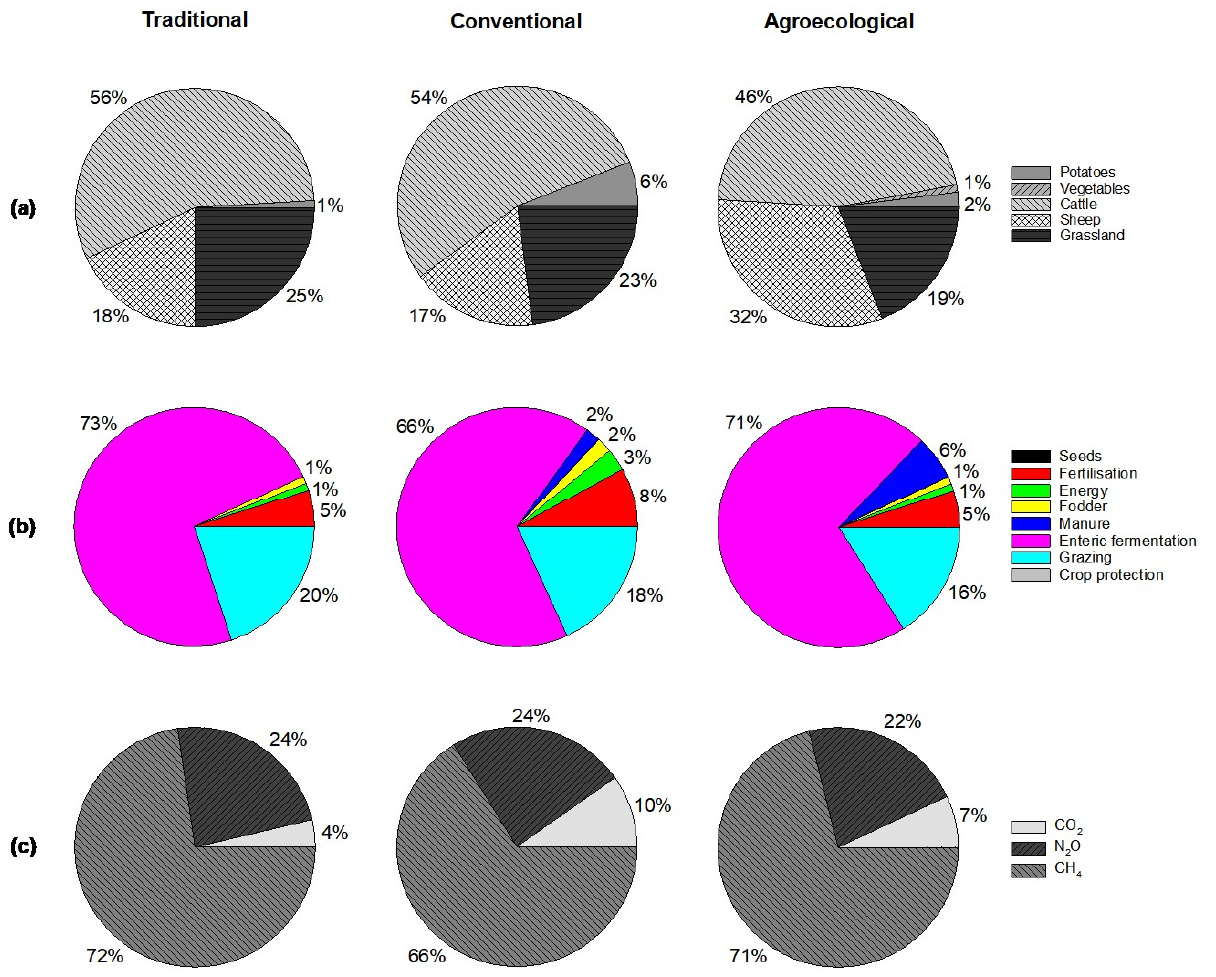
Figure 5. Contribution by sector to the total sum of emissions for each agricultural system: ( a ) contribution by crop and animal categories, some categories are not present in the pie charts because their contribution to total emissions is less than 1%; ( b ) contribution by specific activity or management practice, some categories are not present in the pie charts because their contribution to total emissions is less than 1%; ( c ) contribution of the different greenhouse gases.